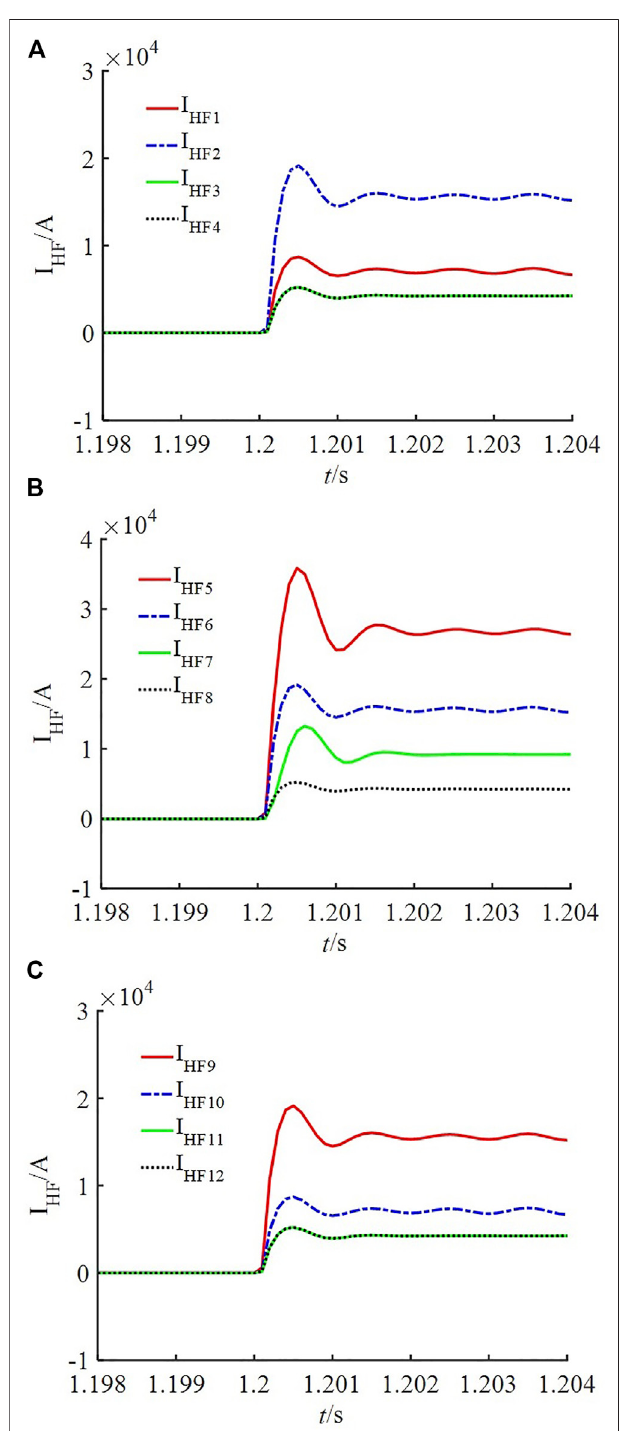
FIGURE 5| High-frequency current waveforms for Line2_5 pole-to-pole fault (A) PZ I (B) PZ II (C) PZ III.